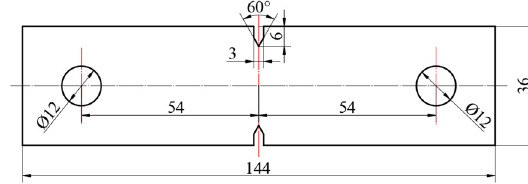
Figure 4 Dimensions of the double edge-notched specimen (unit: mm)